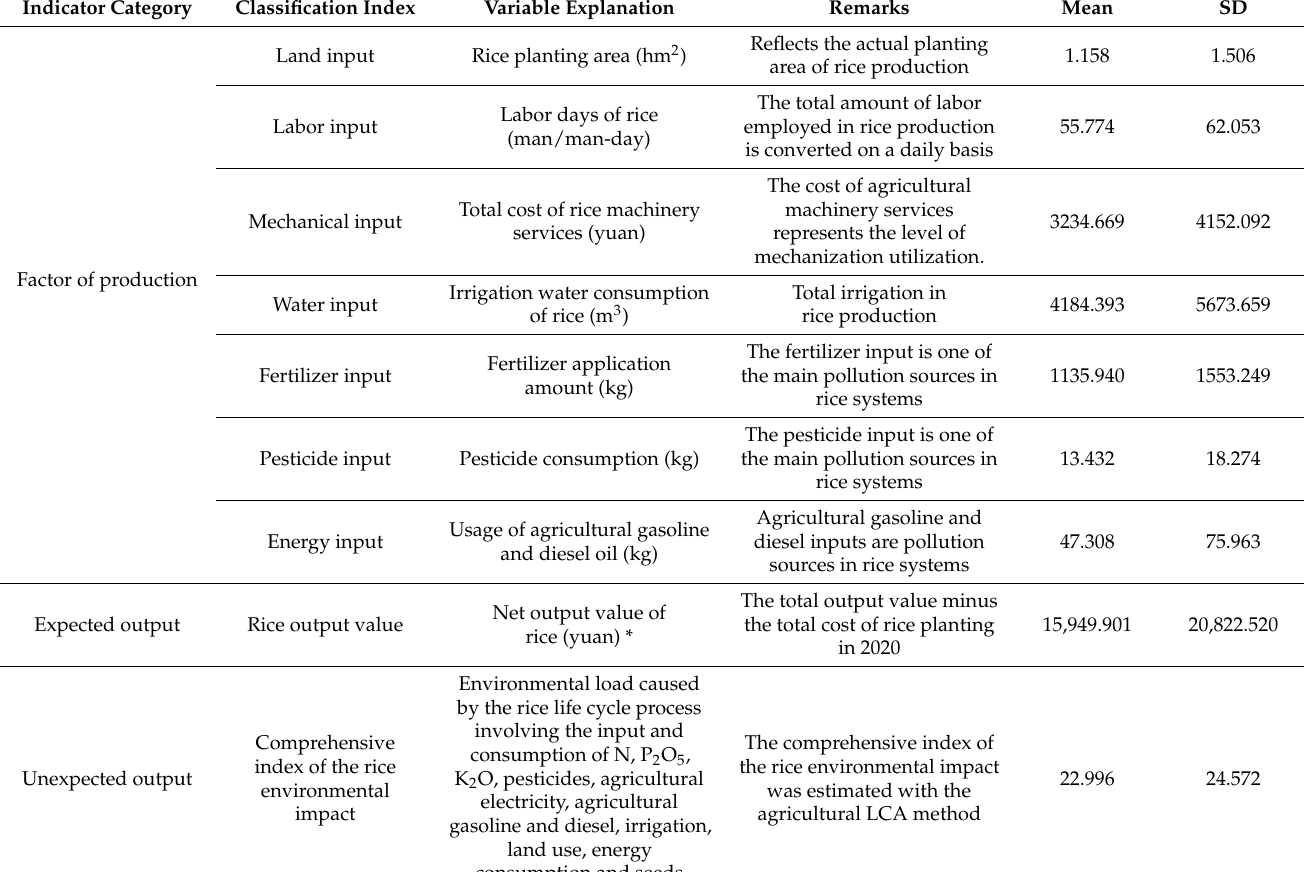
Table 3. Evaluation index system of eco-efficiency of rice